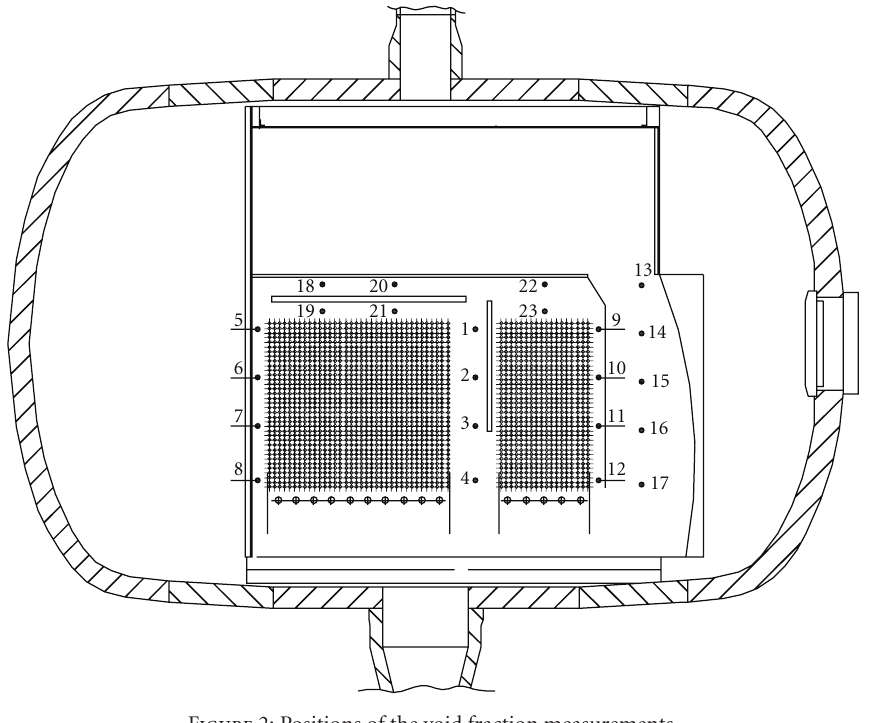
Figure 2: Positions of the void fraction